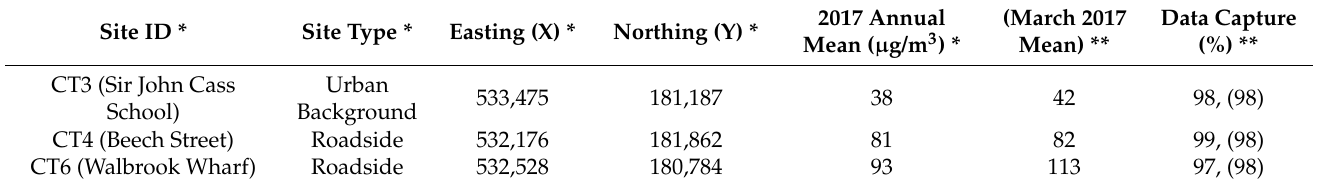
Table 2. CoL CMS NO 2 concentrations ( µ g/m 3 ),